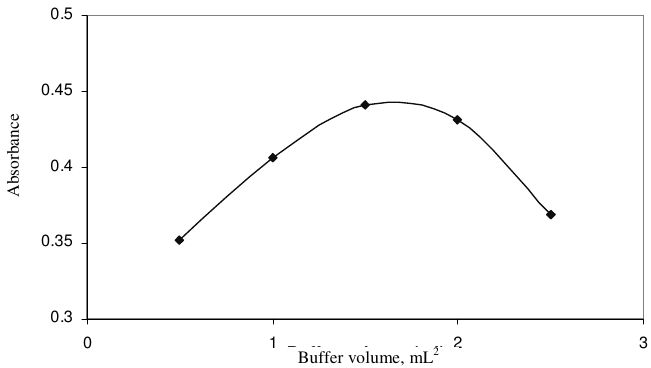
Figure 10. Effect of acetate buffer pH 3.7 volume on the reaction of bromocresol green with 50 µ g mL -1 gabapentin Stoichiometric relationship